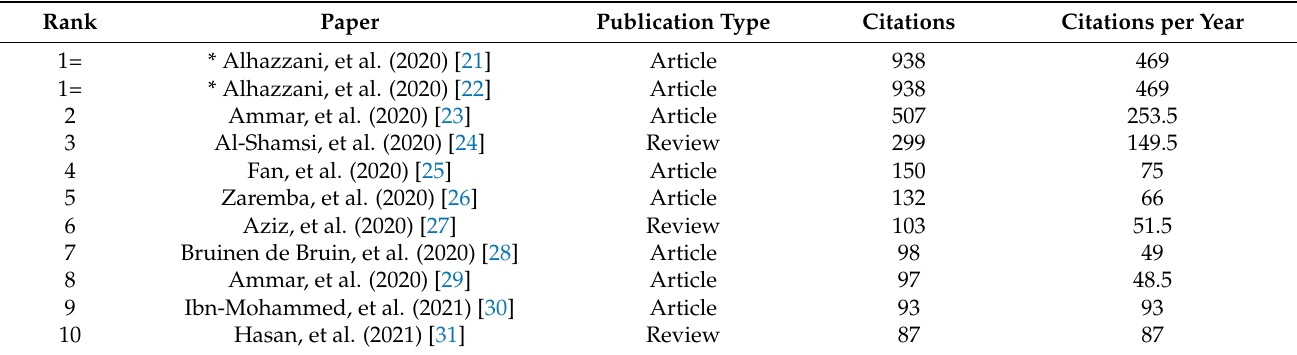
Table 2. Top 10 most cited publications published by UAE-affiliated